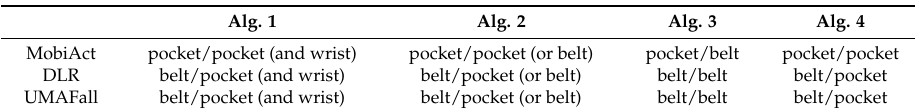
Table 9. Sensor type position in datasets/algorithms. Greyed cells represent a matching sensor position between the dataset and the algorithm.